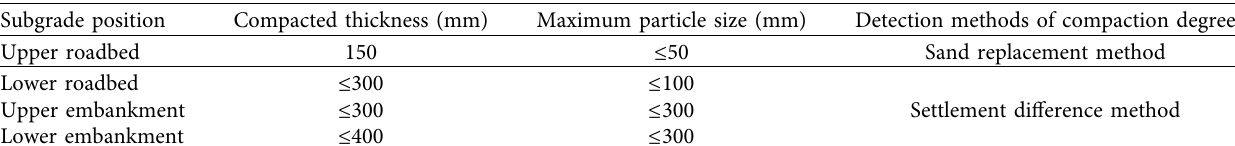
Table 9: Requirements for layered filling thickness and maximum particle size of FSW and detection methods of compaction